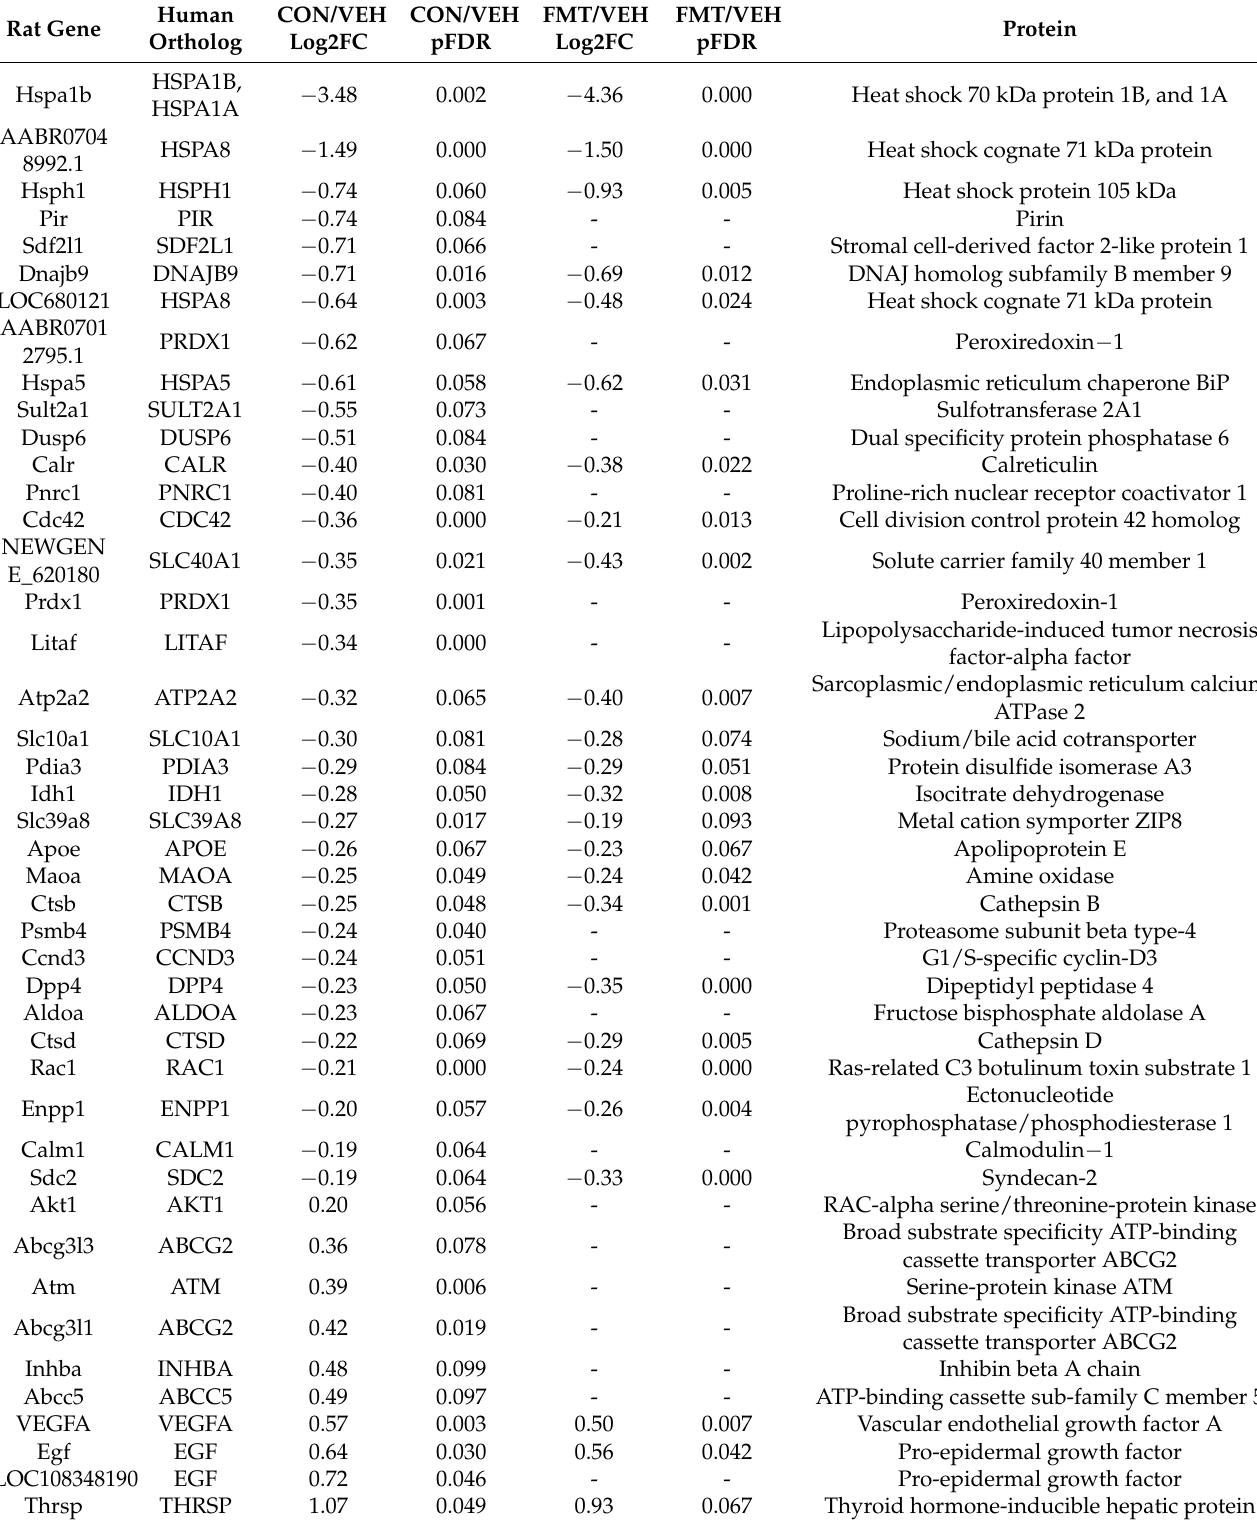
Table 3. Modulation of the top 1000 fatty liver disease genes in the liver of NASH rats. VEH: group of NASH rats receiving sham gavage (vehicle); CON: group of NASH rats receiving the 9-strain bacterial consortium daily; FMT: group of NASH rats receiving fecal microbiota transplantation from control lean rats (1 × transplantation followed by sham gavage).